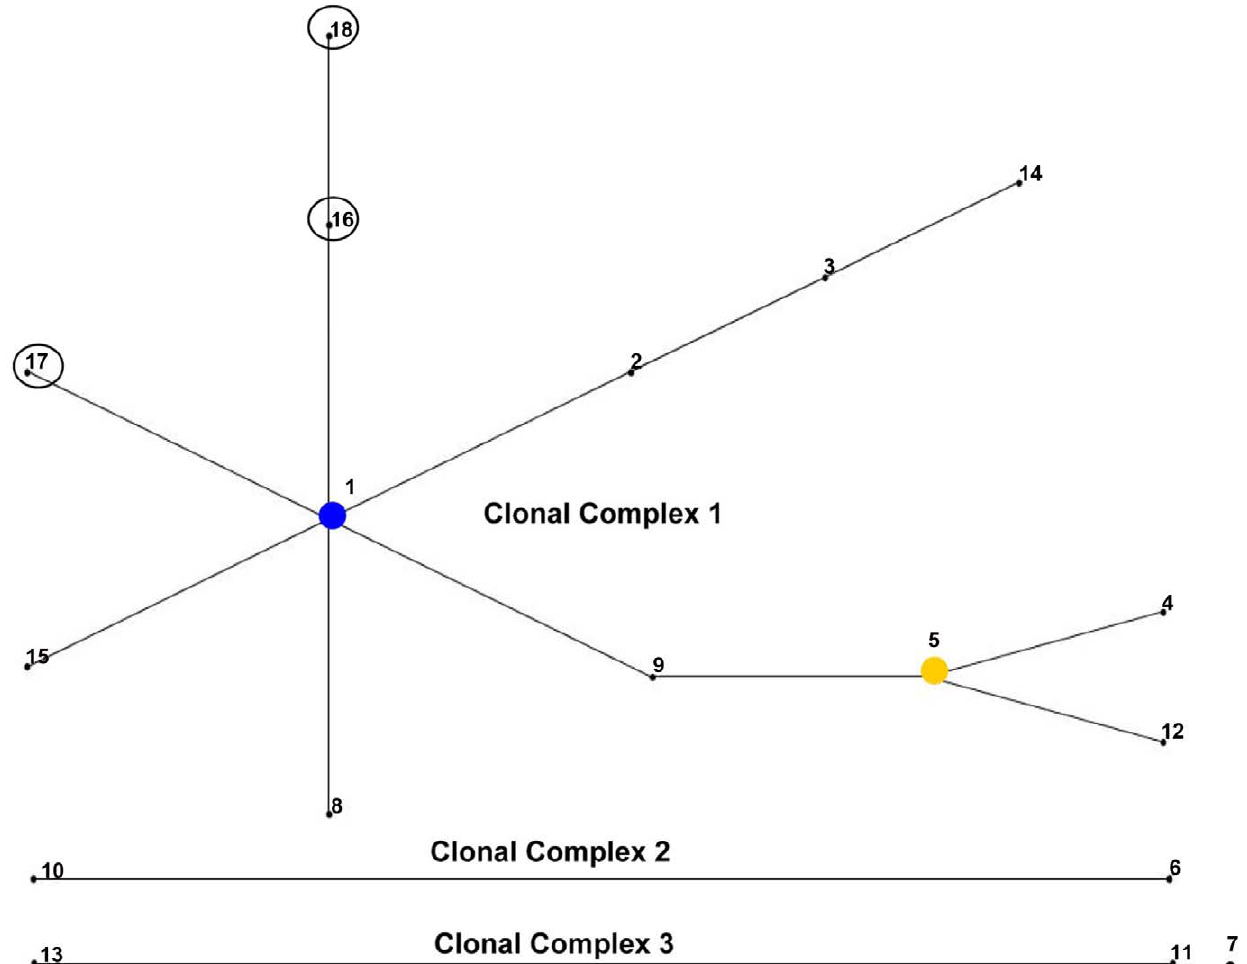
Figure 3. Phylogenetic relationship between the different B . henselae STs as determined by eBURST. The new STs identified in the present study are closely related to ST1. The inclusion of the new STs altered the structure of the phylogenetic tree: ST1 is defined as the primary founder, whereas ST5 is defined as a subgroup founder.